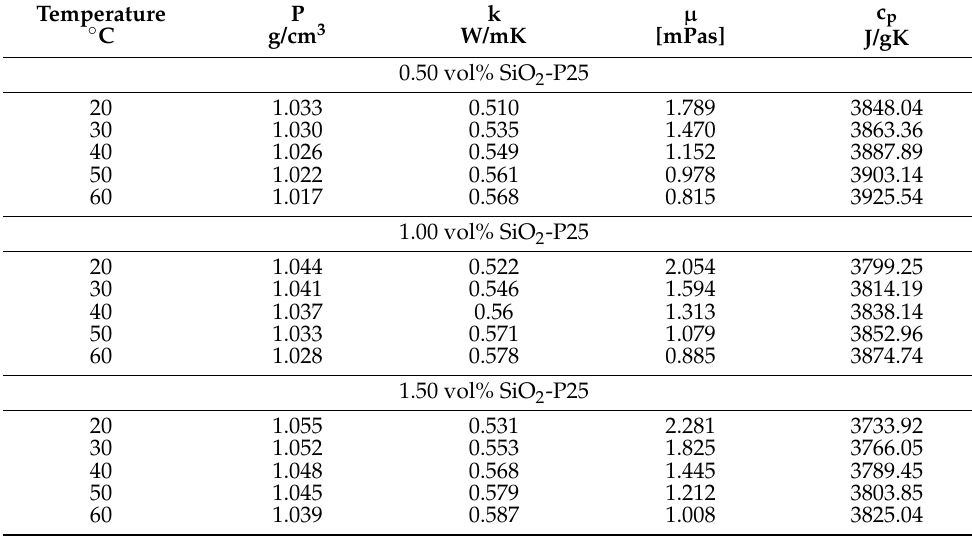
Table 4. The basic properties of SiO 2 -P25 hybrid nanofluids for different